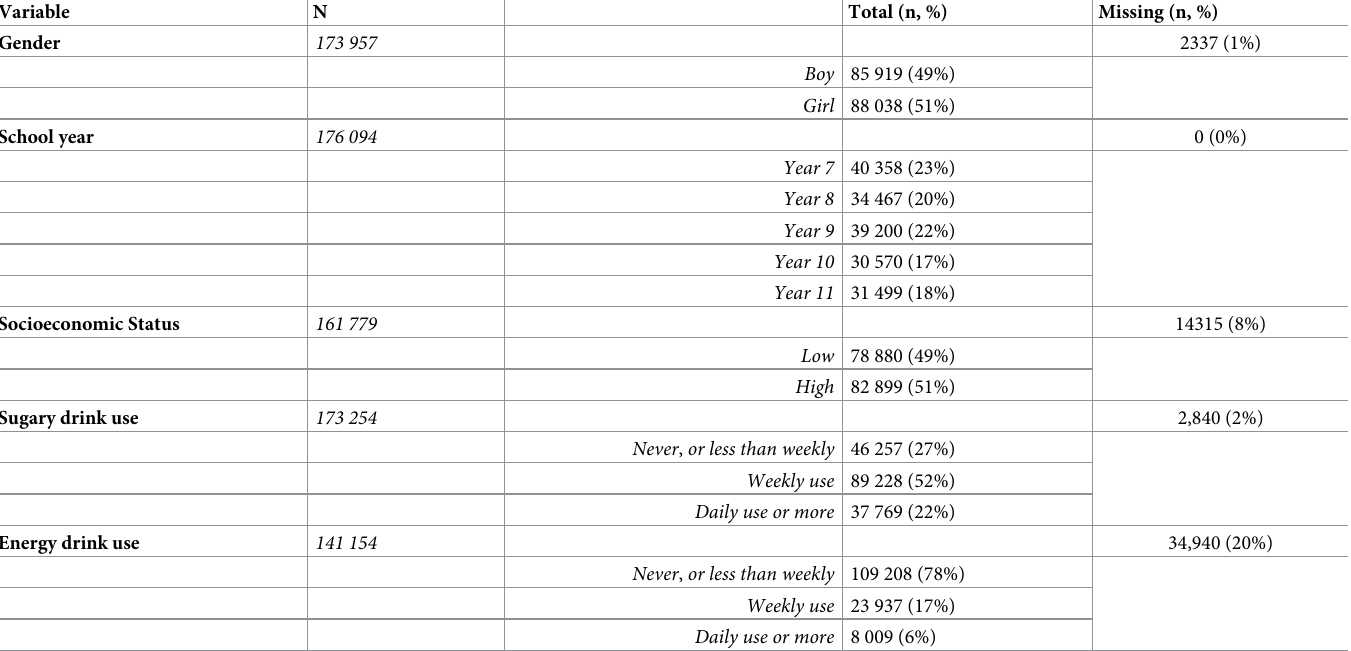
Table 1. Sample characteristics of the study participants (11–16 years) between 1998 and 2017 (n = 176,094). Variable N Gender